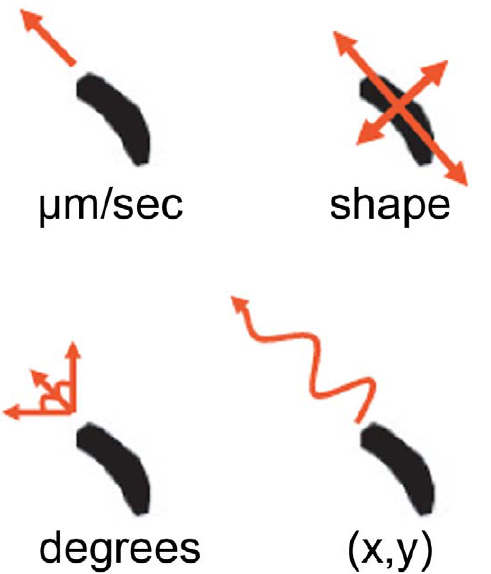
Figure 2. Analysis of Dictyostelium cell behaviour. Cells moving under a chemotactic gradient were analysed using ImageProPlus software to determine cell velocity ( m m/min); cell aspect (shape - measured as a ratio between the diameters of cells across each axis, where a value of 1 represents a circle); cell angle (degrees-where cell migration was measured in comparison to the y-axis); and cell tracking (where the co-ordinates of individual cells were illustrated following normalisation to (0,0) at 5 min) in order to illustrate changes in migration before and after compound addition.